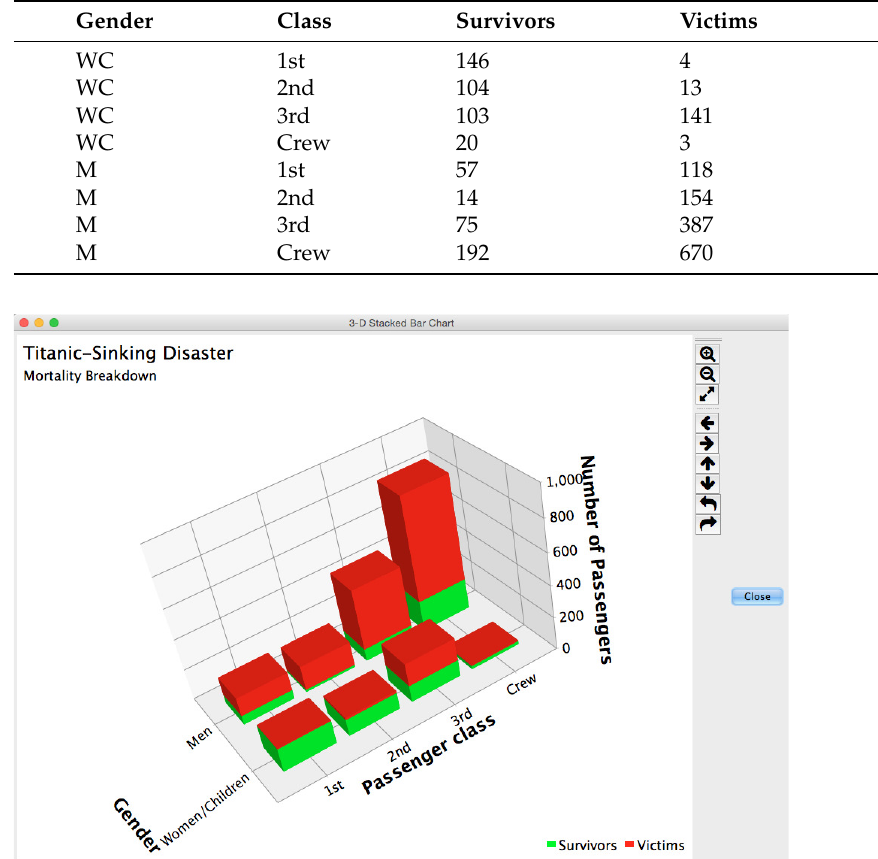
Figure 1. Example 3D stacked-bar plot made by Thoth, which is based on Hall’s Table-1 data [3]. A similar example was first constructed by David Gilbert for demonstrating the Orson Charts